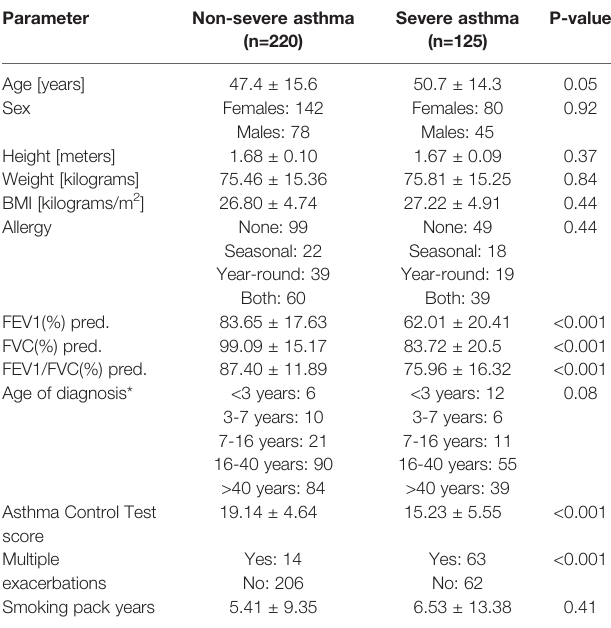
TABLE 3 | Clinical characteristics of asthmatic patients regarding asthma severity, * - uncertain cases were excluded. pred. - predicted.